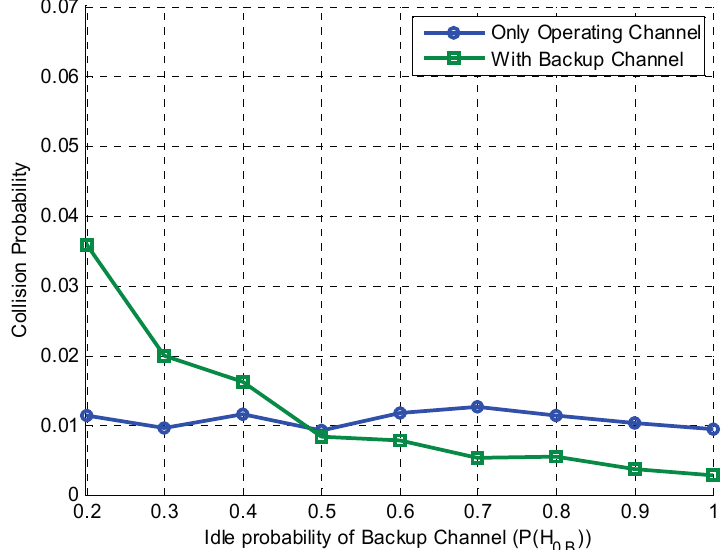
Figure 10. Collision probability of the POMDP-based channel handoff with the backup channel and without the backup channel (operating channel